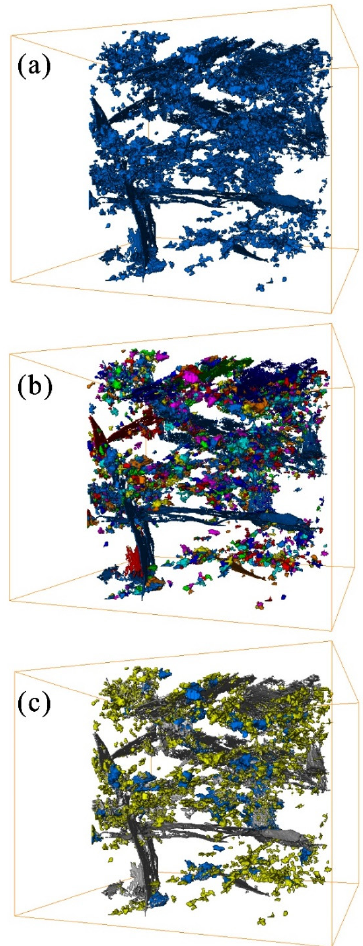
Figure 7. Illustration of ( a ) the acquired pore space, ( b ) segmented individual volumes with watershed method, and ( c ) divided pores, vugs, and fractures according to the geometry of individual volumes.